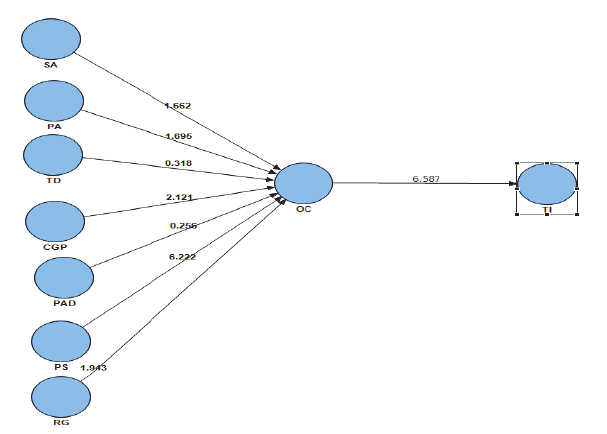
Fig. 2. The indirect effect of